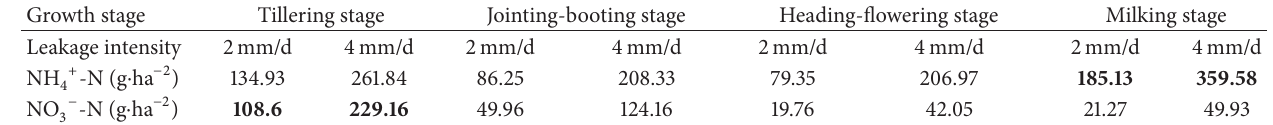
Table 3: N leaching amount of controlled drainage paddy field under two leakage intensity conditions. Growth stage